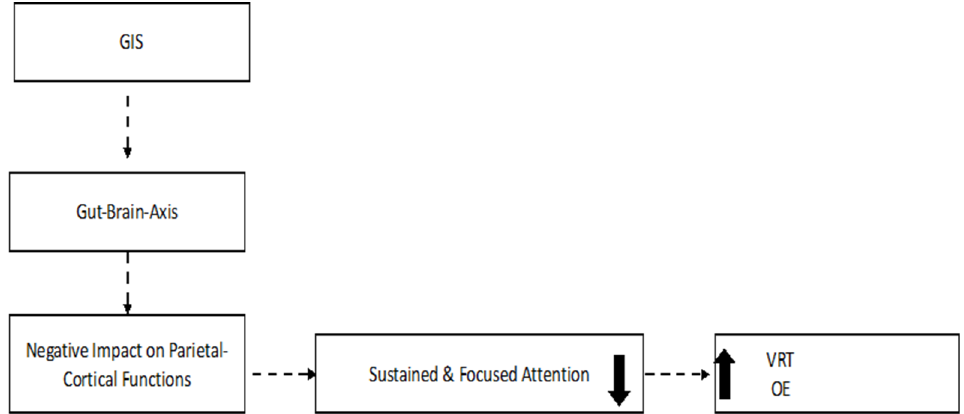
Figure 4. Hypothetical explanation for the attention deficits in the GIS group. GIS = COVID-19 patients with gastrointestinal symptoms; VRT = variability of reaction time; OE = omission errors. The arrows indicate an increase in the VRT and OE variables.